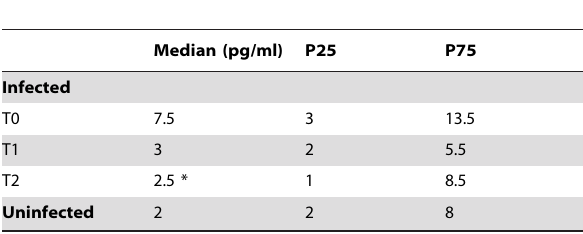
Table 1. Distribution of IFN- c values for T. cruzi -infected and uninfected